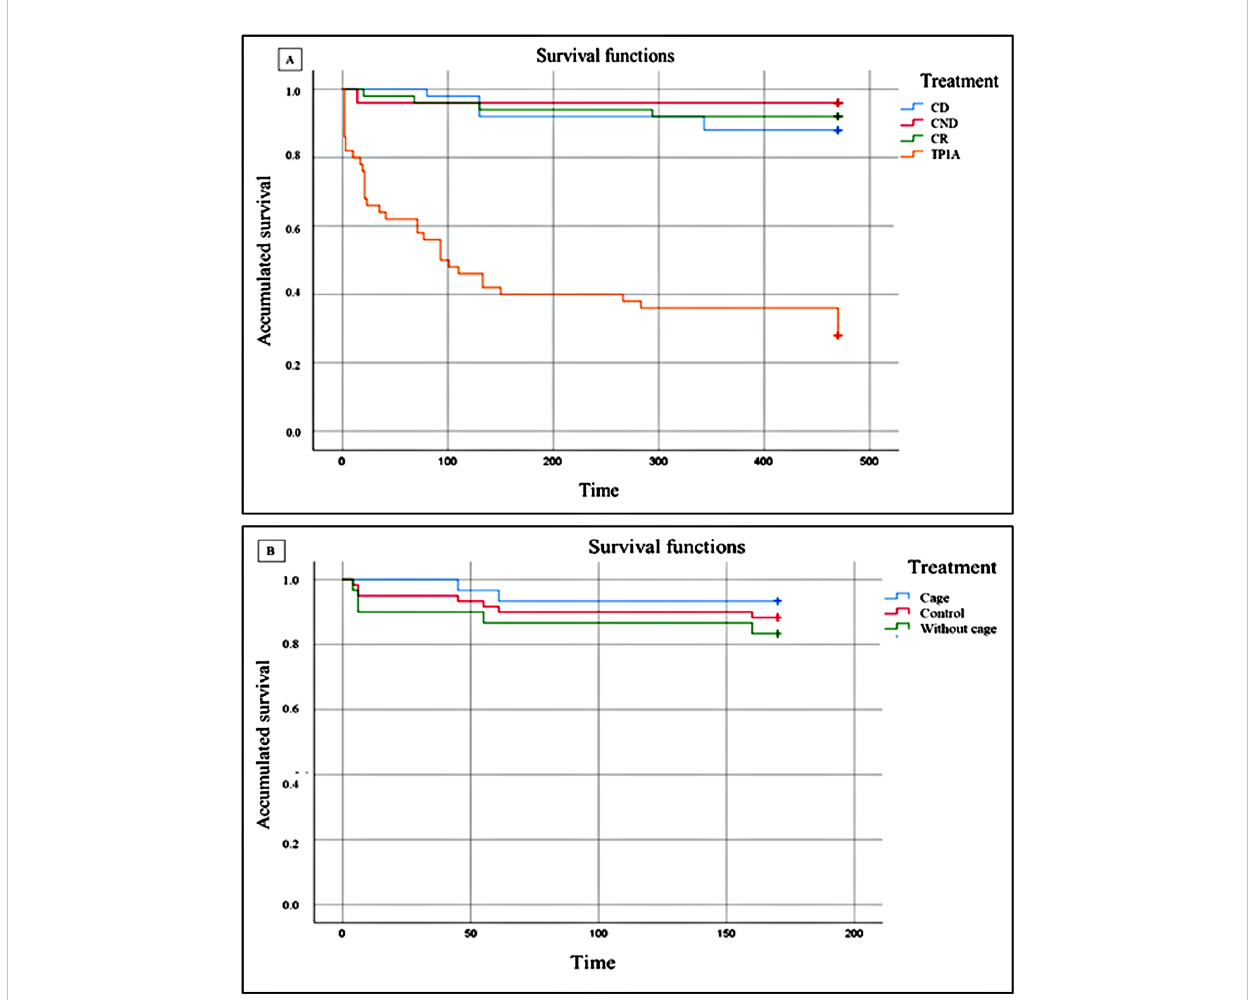
FIGURE 9 Cumulative survival on a linear scale (Kaplan-Meier function). (A) : phase P1 (CD, Control donor; CND, Control non-donor; CR, Control receiver; TP1A, Translocation phase 1A); (B) : phase P2 (P2WCa: with cage, P2Ca: without cage; C2: